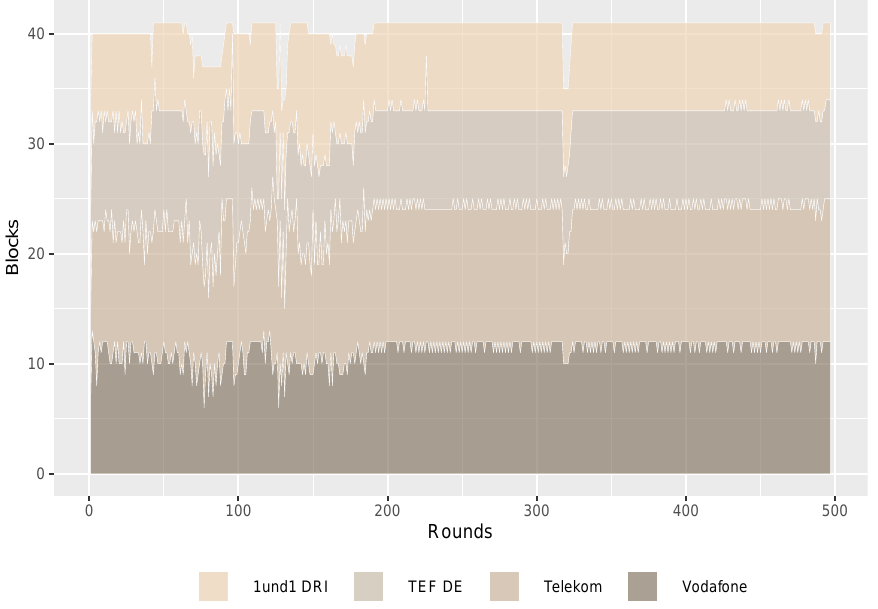
Figure 2. Frequency Blocks per Company . This graph plots the development of the distribution of the 41 frequency blocks among the four bidding companies over the course of the 497 auction